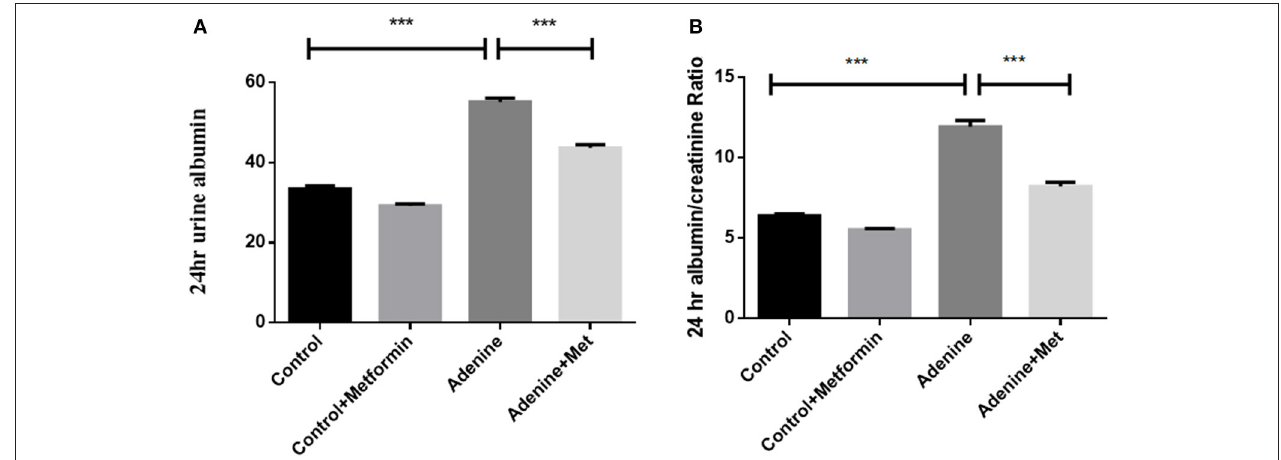
FIGURE 1 | Metformin attenuates adenine-induced renal injury. The 24-h urinary albumin excretion (A) and UACR (B) were significantly increased in adenine-induced mice compared to the control group, which were attenuated by metformin treatment. Data are expressed as mean ± SEM. *** P < 0.001, n = 8.